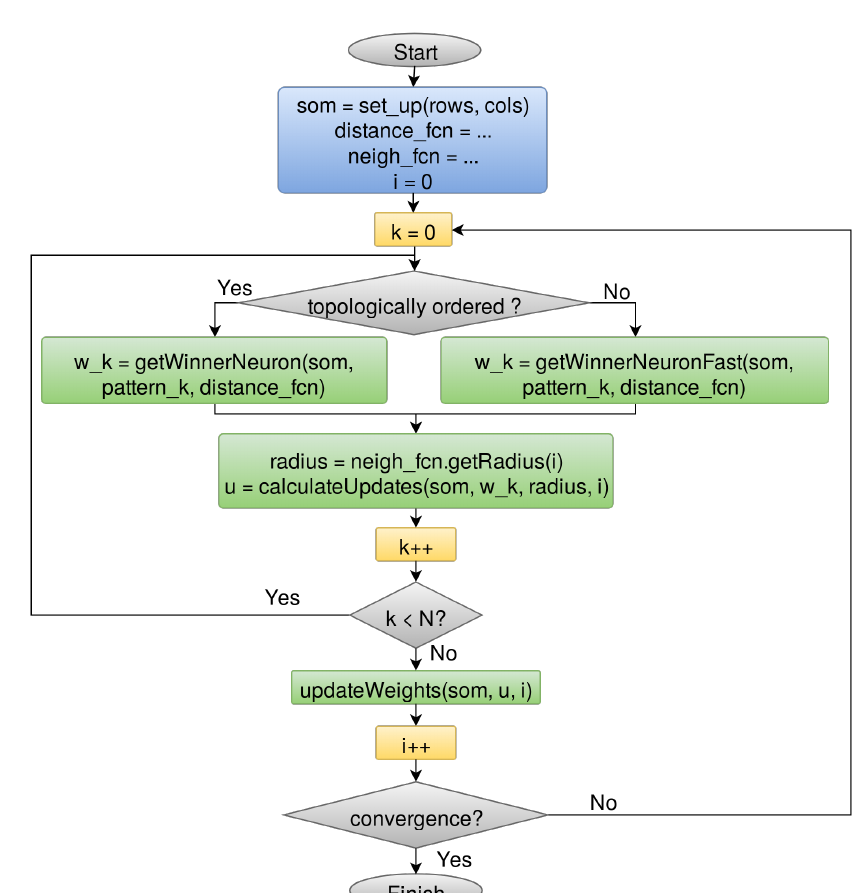
Figure 4. Fast Self-Organized Map (SOM) batch learning algorithm [20]: it starts with a random initialization of the neurons, followed by an adaptation over an iterative process. This includes, for each input source, determining the winner neuron using a distance function and calculating the weights update needed for the winner neuron and the neighbors involved. Once the whole dataset is processed, the weights update is finally committed to the SOM and the convergence criteria are analyzed to check whether it needs to continue iterating or not.